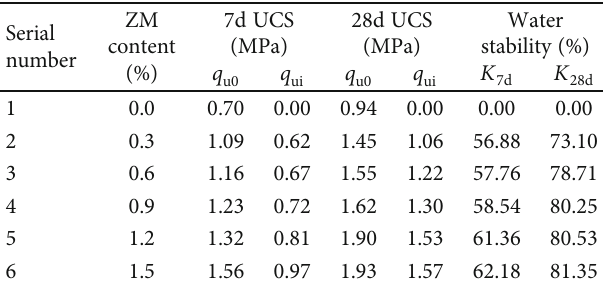
Figure 7: Relative increment of the UCS for di ff erent ZM concentrations and curing periods. Table 4: Water stability of the specimens after di ff erent curing times.